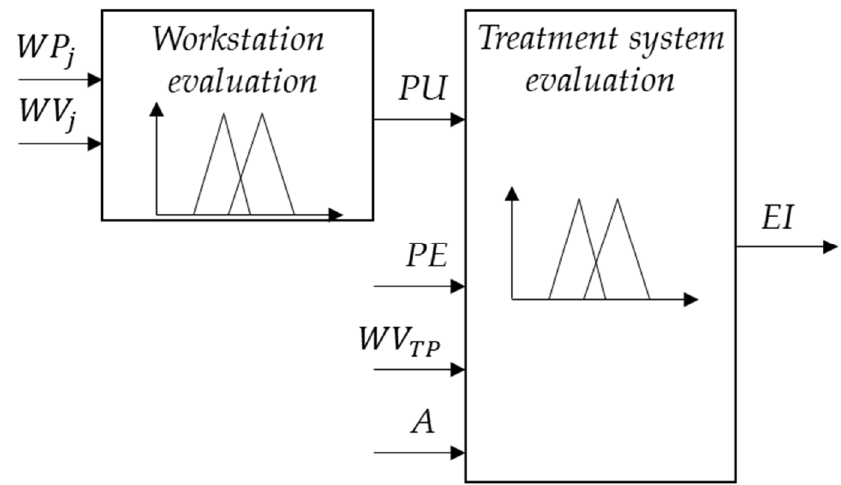
Figure 1. Fuzzy logic model of evaluating municipal waste treatment systems.